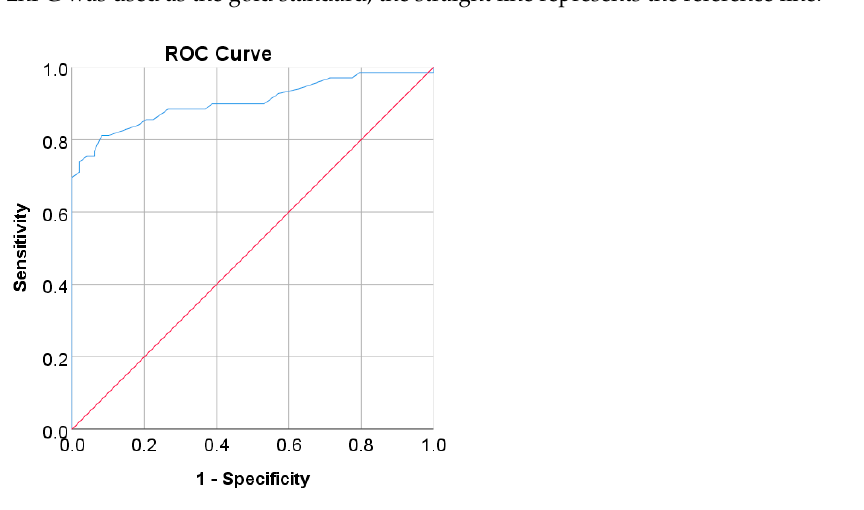
Figure 11. ROC curve for FBG values as a screening test on Trinidadian adult population; FBG was used as the gold standard; the straight line represents the reference